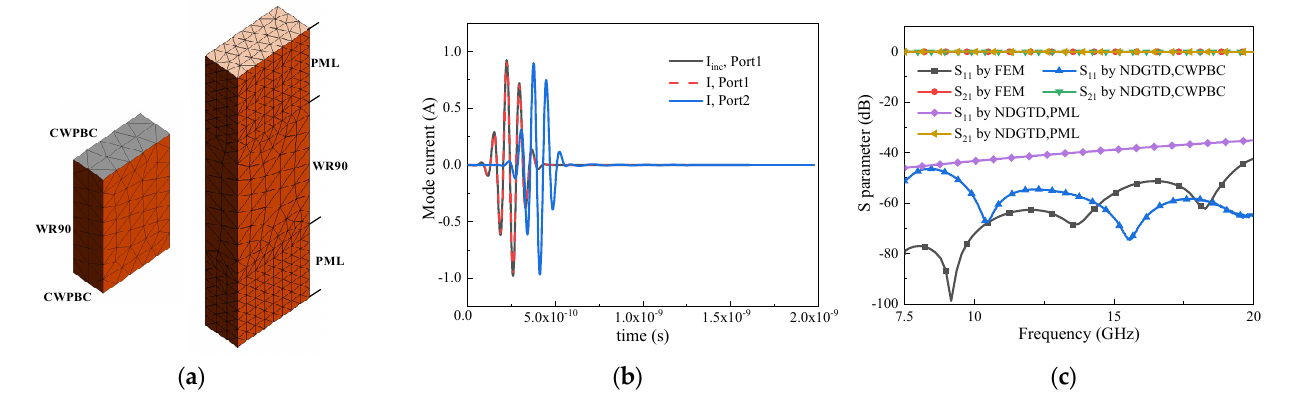
Figure 4. Performance comparison between the CWPBC and the PML: ( a ) topology, ( b ) mode current, and ( c ) S-parameters.